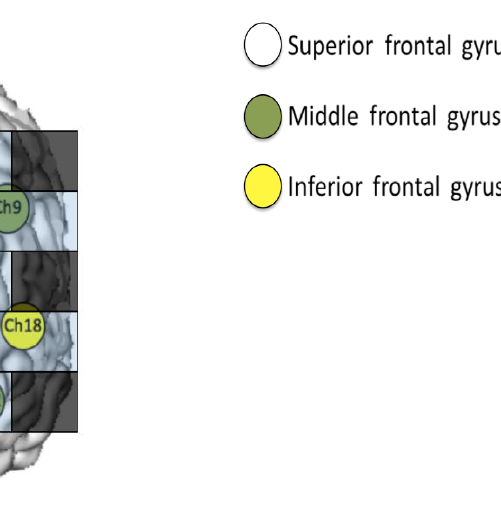
Figure 2. ( a ) A representative oxy image. ( b ) A representative OD image. An image of 5 × 10 pixels was created, and 1 × 2 pixels were assigned to each channel (Ch). The images were converted into gray scale images by 256 gradations, with a maximum value of 255 (white) and a minimum value of 0 (black). As exemplified in ( a ), in the gray scale image of oxy-Hb data or deoxy-Hb data, 1 × 2 pixels represented one cell (green frame, Ch 19). As shown in ( b ), the 1 × 2 pixel is divided in half (blue frame, Ch 19), showing the grayscale image of oxy-Hb data on the left side and deoxy-Hb data on the right side.